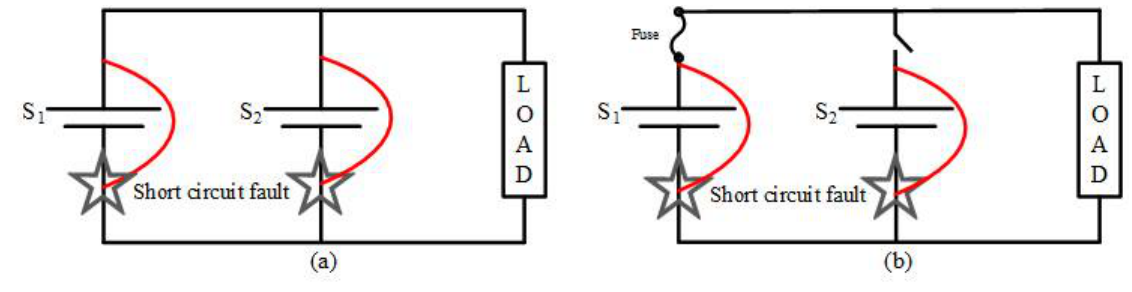
Figure 17. ( a ) Short circuit fault without FTC; ( b ) short circuit fault with FTC.